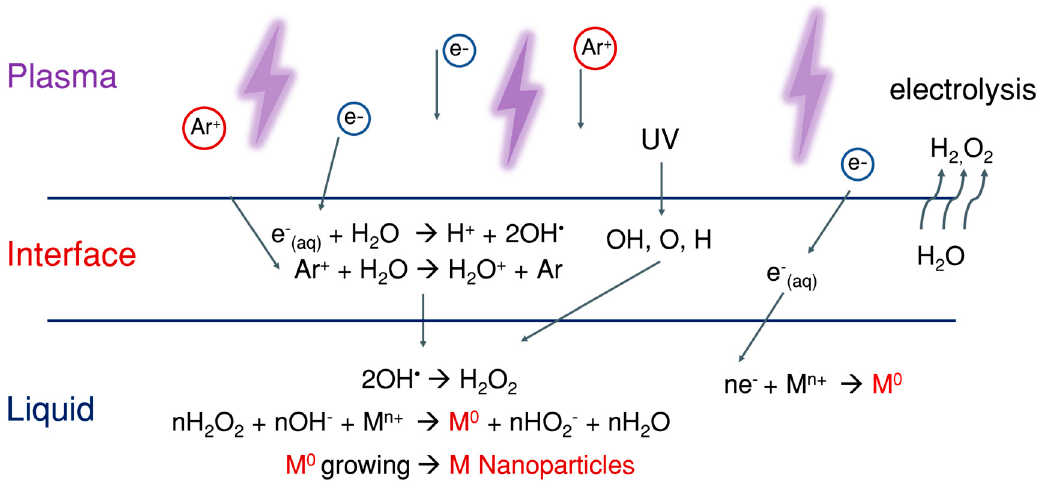
Figure 5. A schematic illustration of the metal ion reduction, diffusion and nucleation at the plasma-liquid interface. The reduction reactions can occur in liquid medium by either solvated plasma-induced electron or plasma induced reactive species.